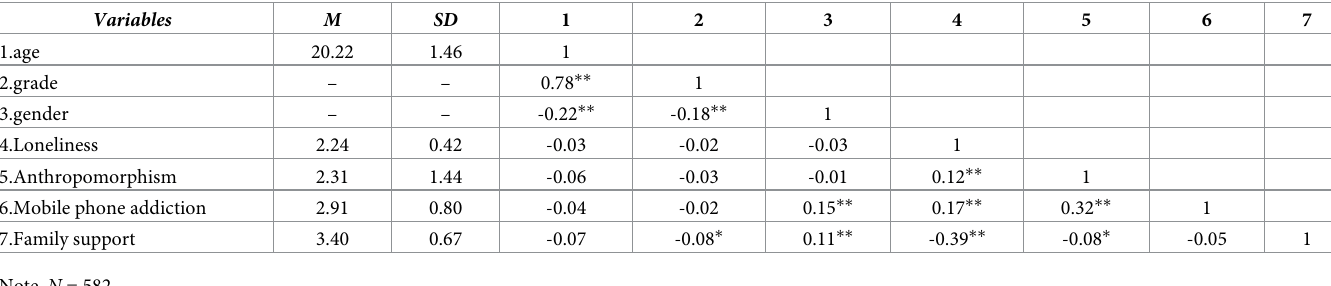
Table 1. Descriptive statistics and interrelations among all of the observed